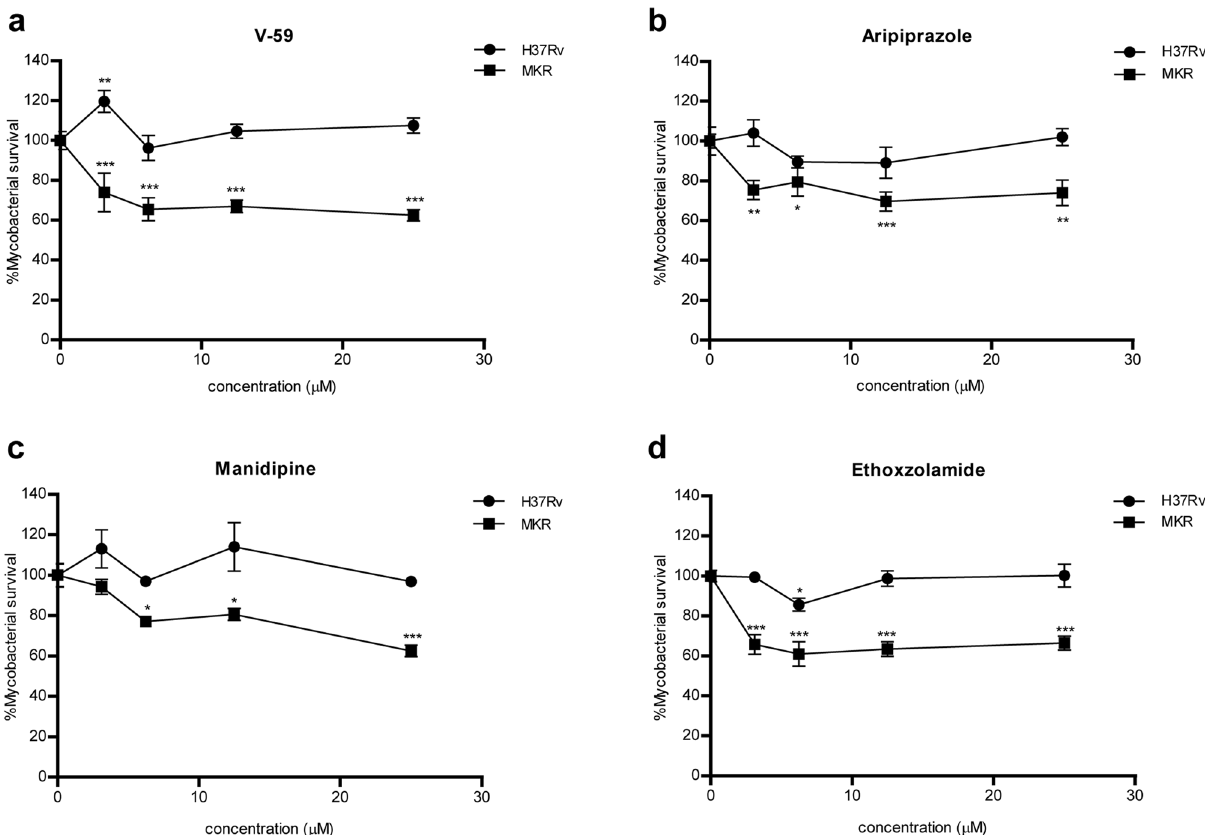
Figure 5. Intracellular survival odds of the MKR superspreader and H37Rv upon the treatments of V-59, aripiprazole, manidipine and ethoxzolamide. ( a–d ) THP-1 cells were infected with mCherry-expressing MKR superspreader or H37Rv for 30 min, and were treated with media containing various concentrations of ( a ) V-59, ( b ) aripiprazole, ( c ) manidipine and ( d ) ethoxzolamide for 3 days. Cells were then fixed and processed for